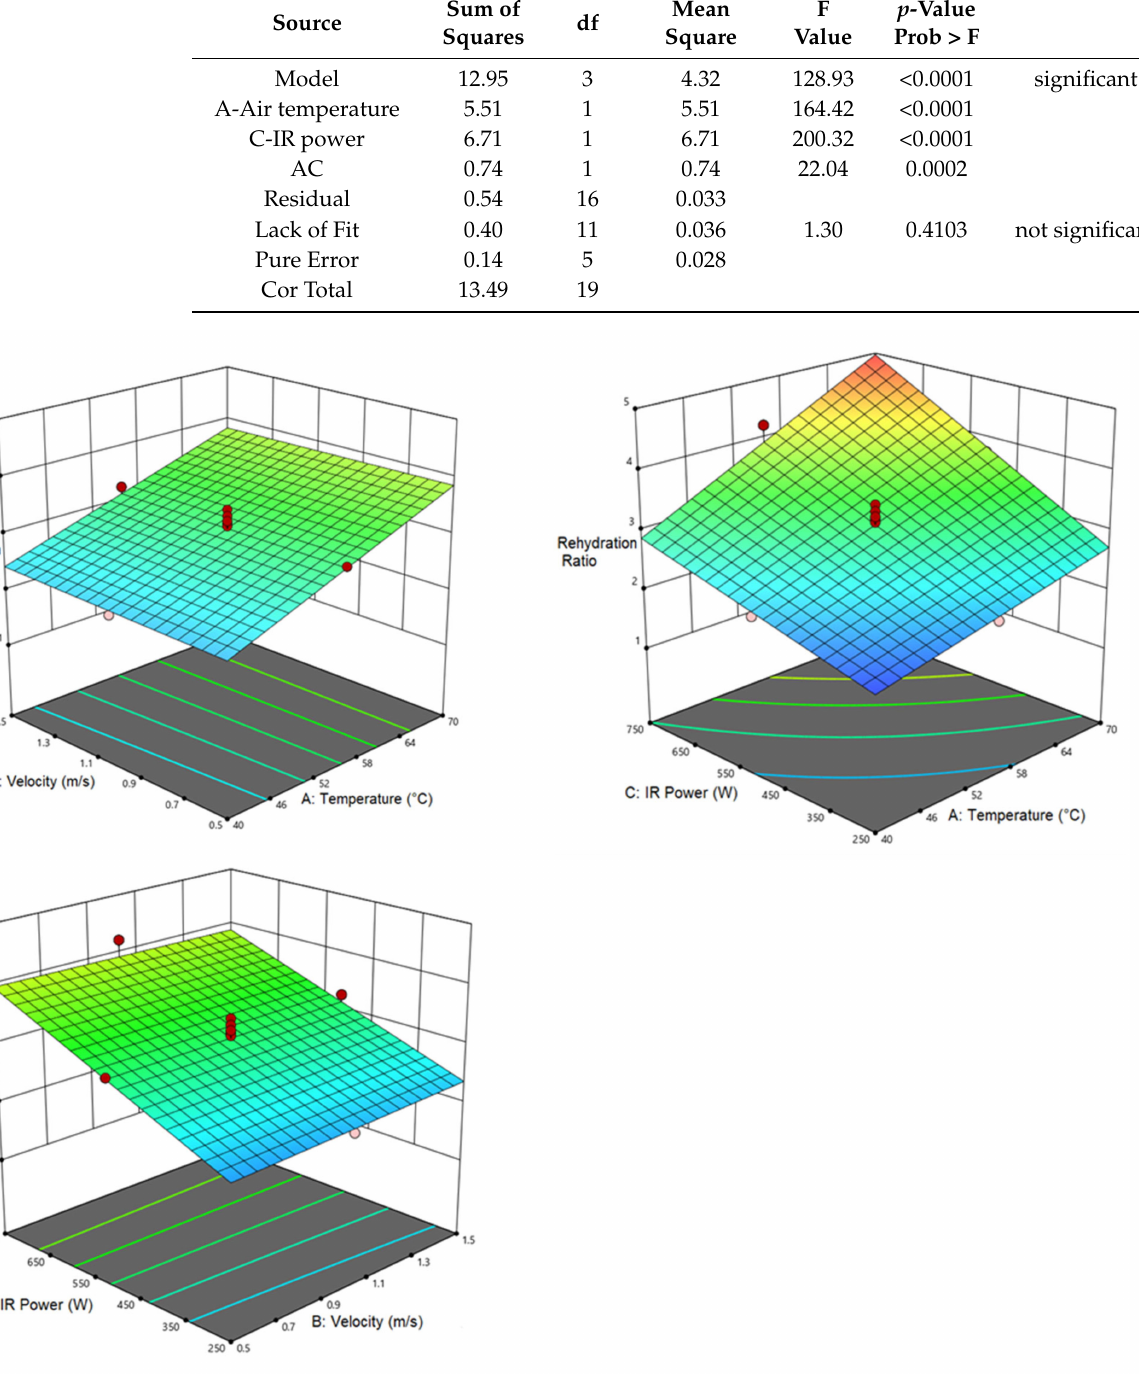
Table 9. Analysis of variance for RR response using RSM.